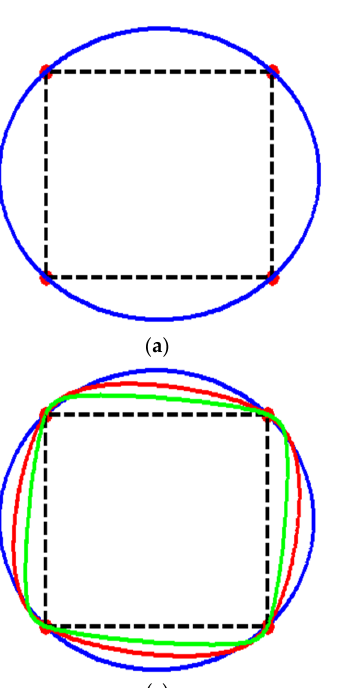
Figure 10. ( a – d ) are RQTS curve through biased tension, by ρ i = 2, 3, 5, and 10 ∀ i .